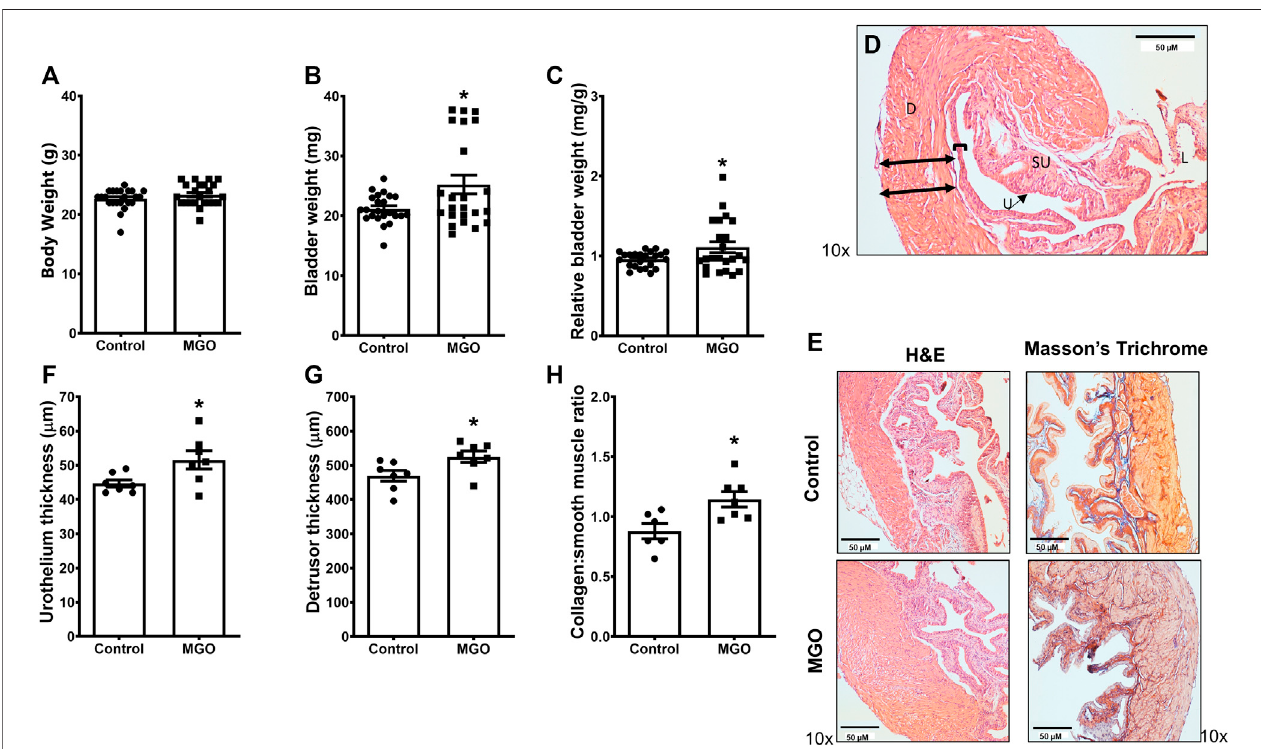
FIGURE 2 | Bladder measures and histological evaluation of methylglyoxal (MGO)-treated mice in comparison with control animals. Panels (A − C) show body weight, bladder weight and relative bladder weight, respectively, in control and MGO groups. Panel (D) shows a histological image of a bladder from control mice indicating the urothelium and detrusor smooth muscle with double-black arrows indicating the limits of quanti fi cation in detrusor and brackets indicating limits of quanti fi cation inurothelium.Panel (E) showsrepresentative histologicalimages ofbladdersofcontroland MGOgroups usingcross-sectionhematoxylinand eosin (HE) and Masson ’ s trichrome staining. Panels (F − H) show quanti fi cations of urothelium thickness, detrusor thickness and collagen content, respectively. Data are expressed as mean ± SEM ( n = 23 for body weights; n = 7 for urothelium thickness, detrusor thickness and collagen content). * p < 0.05 compared with control group (unpaired t -test). D , detrusor smooth muscle; SU, suburothelium, U , urothelium; L, lumen. Black bars in panels D and E represent a scale of 50 µm (×10